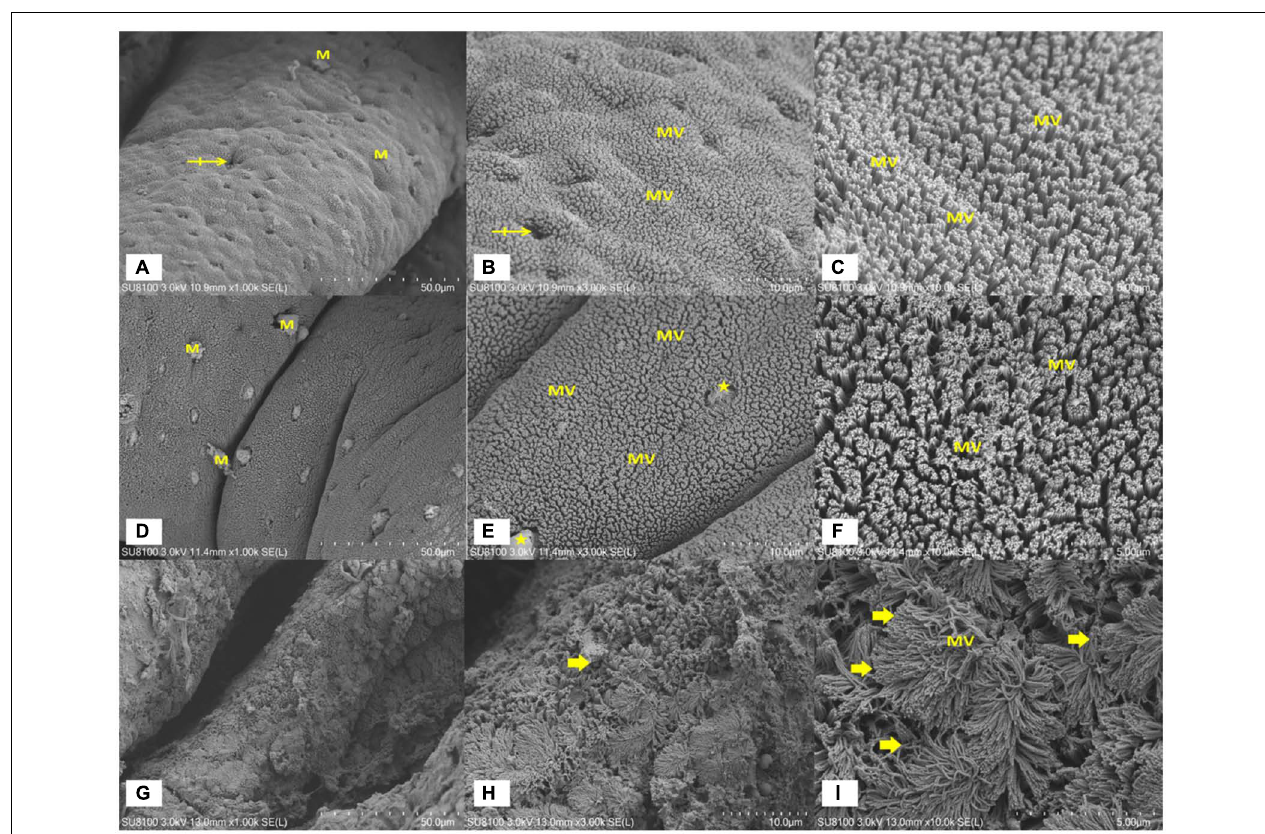
FIGURE 2 | A scanning electron microscopy (SEM) of the distal intestinal mucosal surface of juvenile hybrid grouper fed with FM (A–C) , CM4 (D–F) , and CM20 (G–I) . Bar markers represent 50 µ m (A,D,G) , 10 µ m (B,E,H) , and 5 µ m (C,F,I) . (A–C) Shows more and pebbled mucosal surface or villi (MV) density which contains orifices of several goblet cells that may be seen protruding mucus (M) or not (crossed arrow); (D–F) shows more and pebbled mucosal surface or villi (MV) density which contains orifices of several goblet cells that may be seen protruding mucus (M) in addition to very few noticeable villi detachments of from the epithelial layer (stars); (G–I) shows few and weak mucosal surface or villi (MV) density, irregular orientation of villi, villi atrophy or blunting (flattening) causing some villi to disappear (arrows). Abbreviations are as defined in Figure 1 .